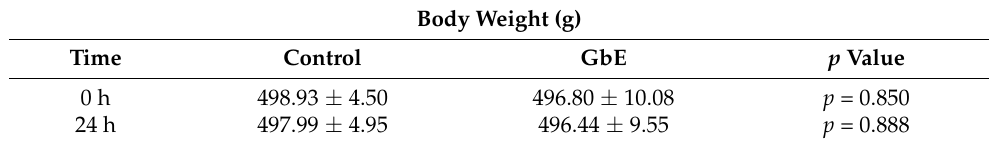
Table 2. Body weight (g). n =